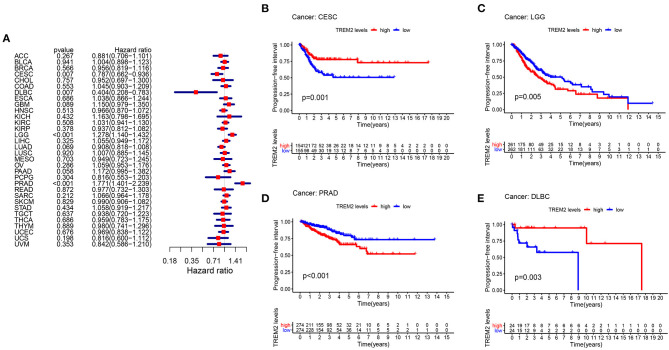
Association between TREM2 expression and progression-free interval (PFI). (A) Forest plot of PFI association with TREM2 expression in 33 tumor types. (B–E) Kaplan-Meier analysis of the association between TREM2 expression and PFI.